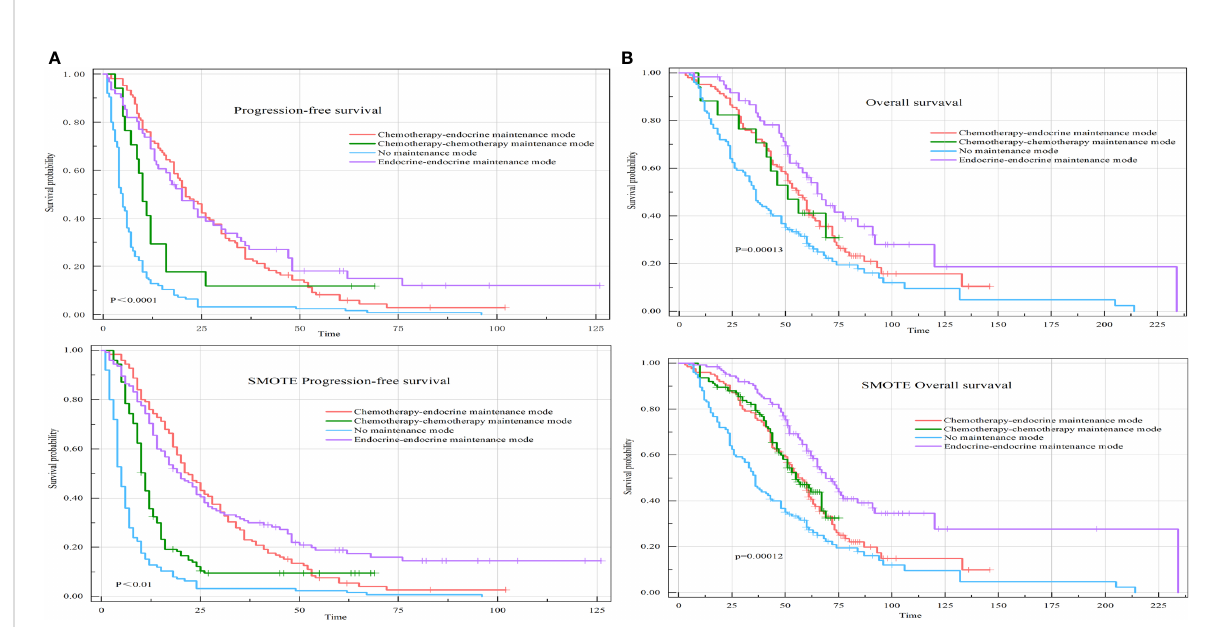
FIGURE 4 PFS and OS of HR+HER-2-MBC patients were treated with four different maintenance treatment modes. (A) Kaplan – Meier curve of PFS in maintenance treatment modes. (B) Kaplan – Meier curve of OS in maintenance treatment